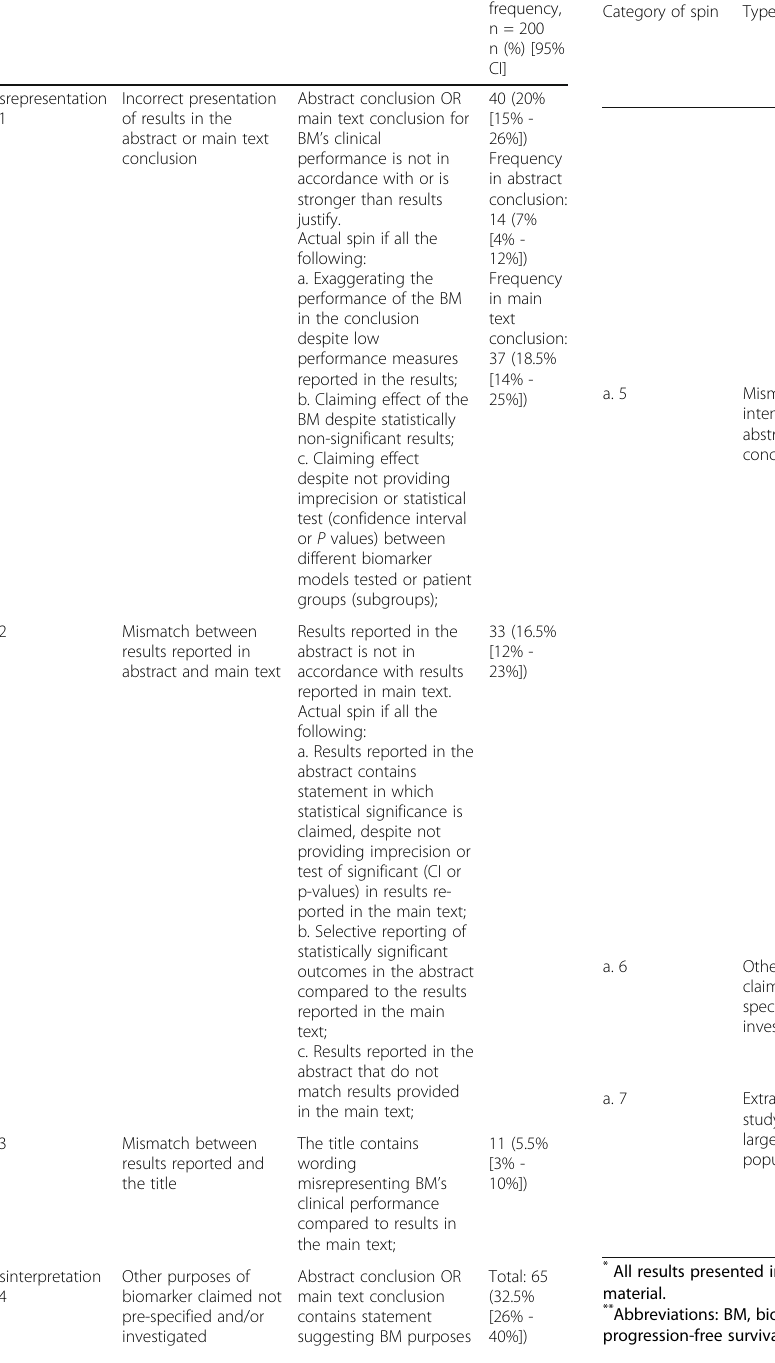
Table 1 (abstract P25). Actual forms of spin in clinical studies evaluating performance of biomarkers in ovarian cancer with examples